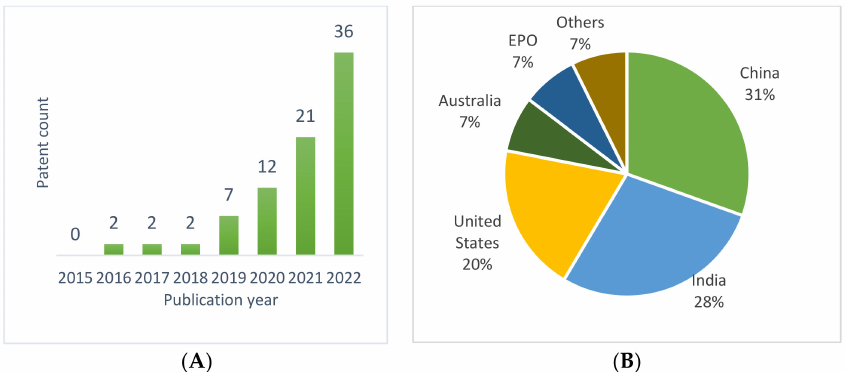
Figure 4. Patent portfolio publication trend ( A ) and authorities of the portfolio applications ( B